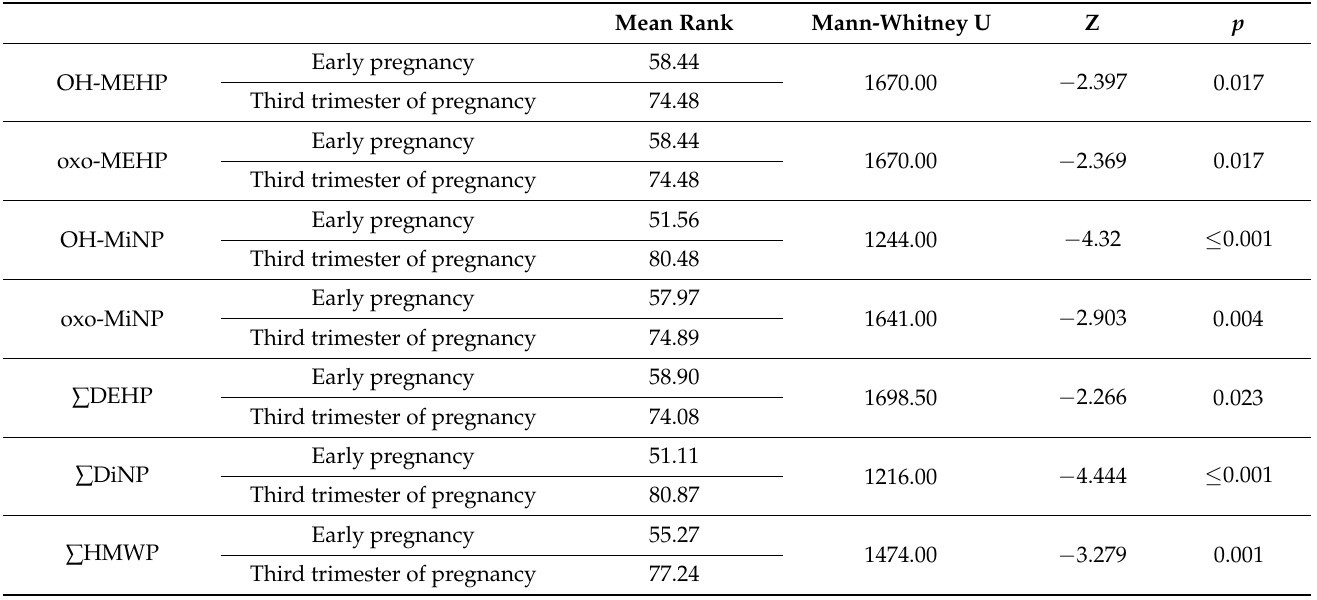
Table 5. Comparison of phthalate concentrations between early pregnancy and third trimester